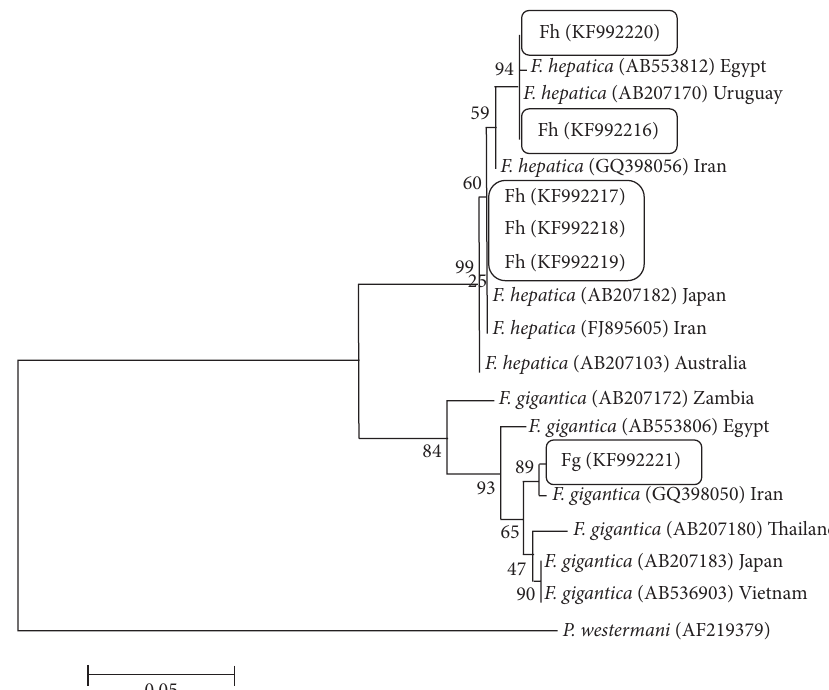
Figure 7: Phylogenetic relationship of COI sequences of isolates of Fasciola hepatica and Fasciola gigantica from Iran using Maximum Likelihood method. Paragonimus westermani (AN: AF219379) was used as the out group.